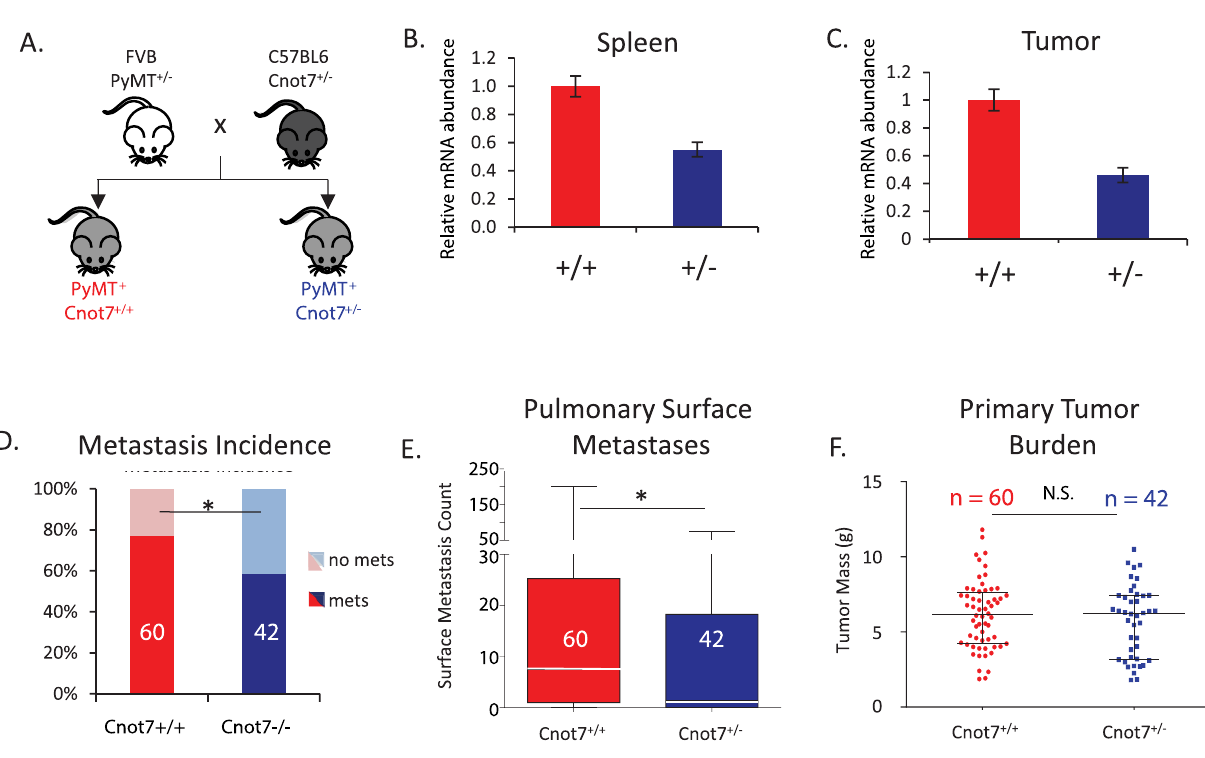
Fig 2. (A) Design of the MMTV-PyMT x Cnot7 knockout mouse cross experiment. (B) Relative expression of Cnot7 mRNA in the spleens of control and heterozygous knockout animals. (C) Relative expression of Cnot7 mRNA in bulk primary tumors of control and heterozygous knockout animals. (D) Incidence of macroscopic pulmonary metastases (mets) for the PyMT + Cnot7 +/+ and PyMT + Cnot7 +/- animals. The number of animals in each group is indicated by the numbers in the histogram bars. (E) Mean number and standard deviation of metastases observed for the PyMT + Cnot7 +/+ and PyMT + Cnot7 +/- animals. Median values for each genotype are indicated by white line across the histogram bar. (F) Total tumor mass for the PyMT + Cnot7 +/+ and PyMT + Cnot7 +/- animals. N.S. = not significantly different. * = p < 0.05.